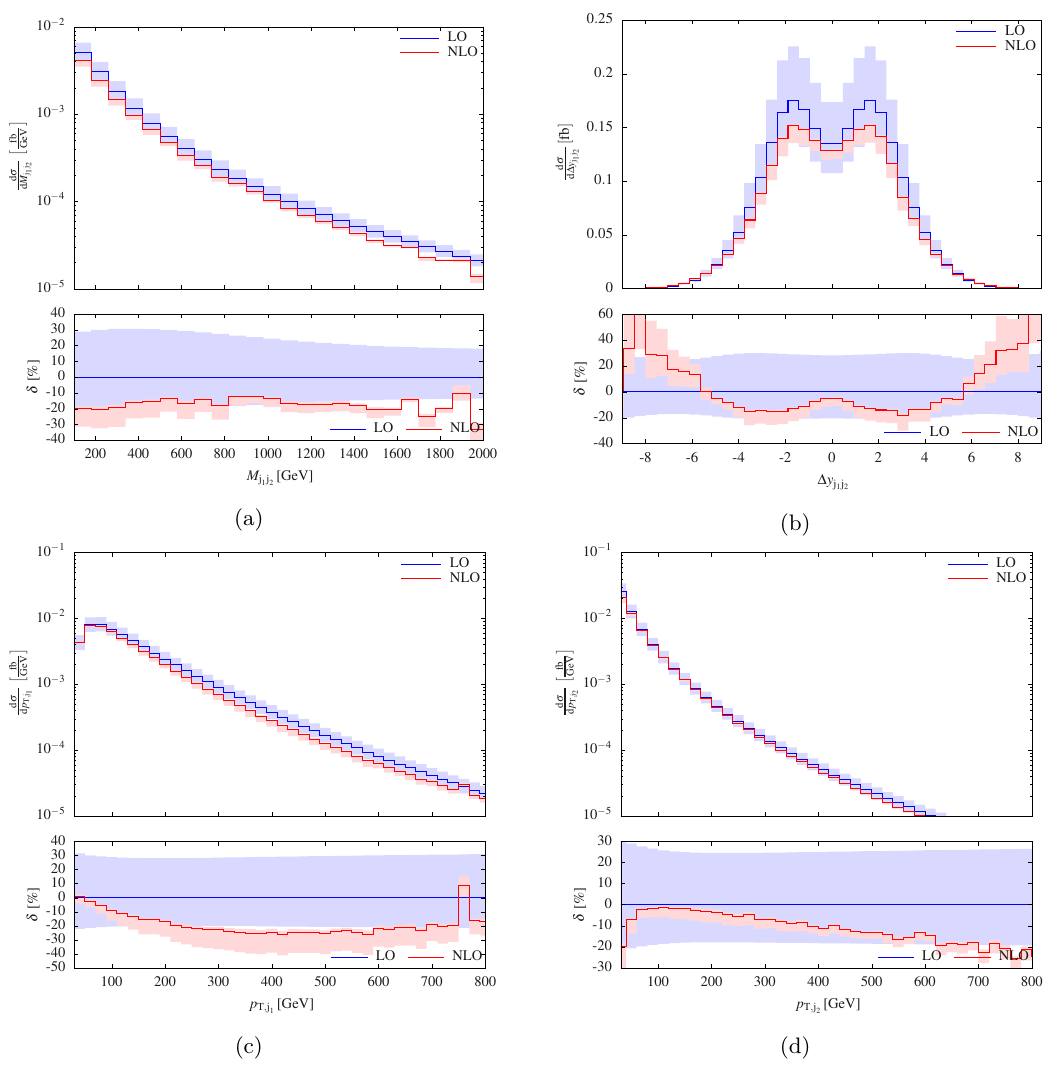
Figure 8 . Differential distributions including 7-point scale uncertainties. The upper panels show absolute predictions for LO and NLO while the lower ones show relative NLO corrections with respect to the LO predictions at the central scale and the relative LO scale uncertainty. The full LO predictions include orders O ( α 6 ) , O ( α s α 5 ) , and O ( α 2 α 4 ) , while the NLO ones comprise O ( α 7 ) , s O ( α s α 6 ) , O ( α 2 α 5 ) , and O ( α 3 α 4 ) contributions. The observables read as follows: invariant mass of s s the two tagging jets (top left), rapidity difference between the two tagging jets (top right), transverse momentum of the hardest jet (bottom left), and transverse momentum of the second hardest jet (bottom